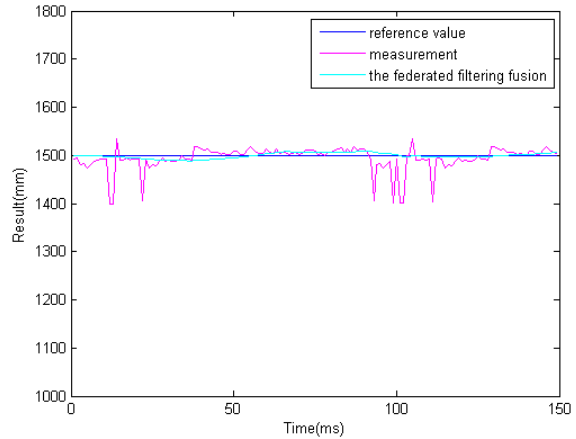
Figure 18. The results of information fusion based on an adaptive Kalman filter using binocular cameras and two ultrasonic sensors at 1.5 m.